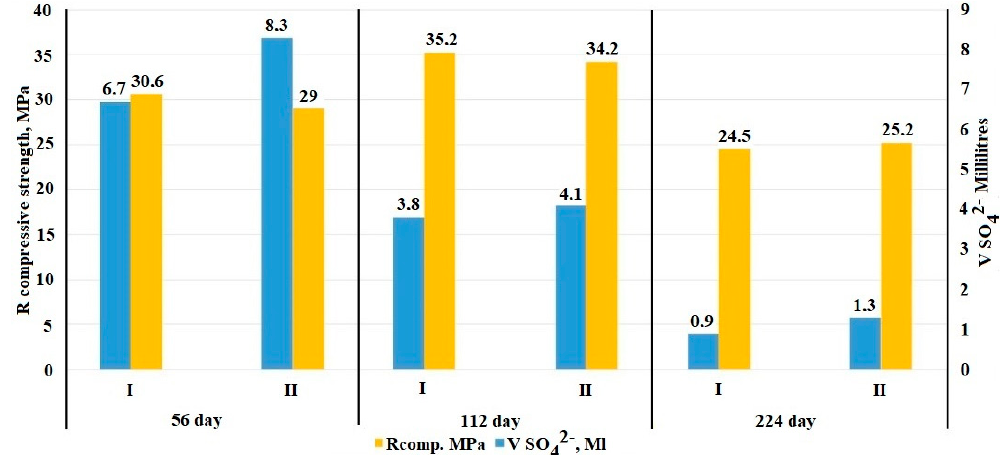
Figure 2. Correlation of data on the volume of absorbed SO 42– ions from a 1 N aqueous solution of sodium sulfate by samples of control and electrically conductive concrete with a change in strength characteristics (Note to Figure 1. The value of the coefficient of variation was V = 6.7% (control composition—I) and V= 7.1% (electrically conductive composition—II).